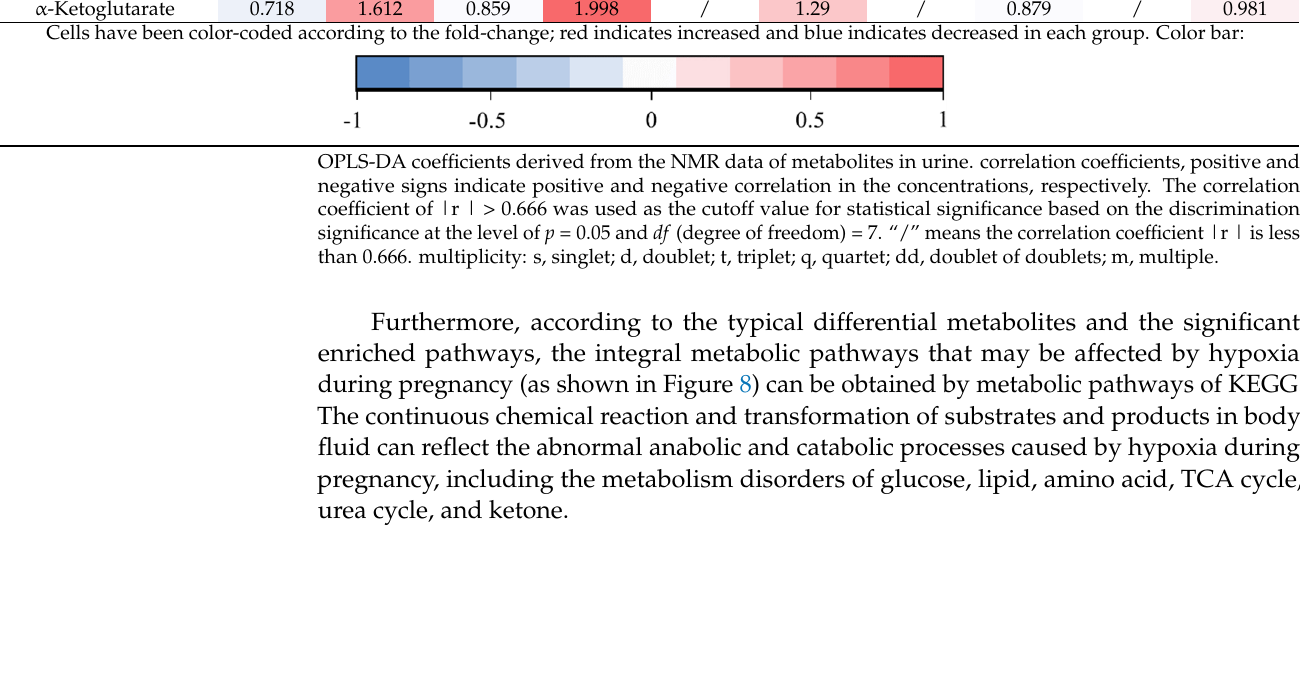
Table 2. Differences in urine metabolism between hypoxia group and control